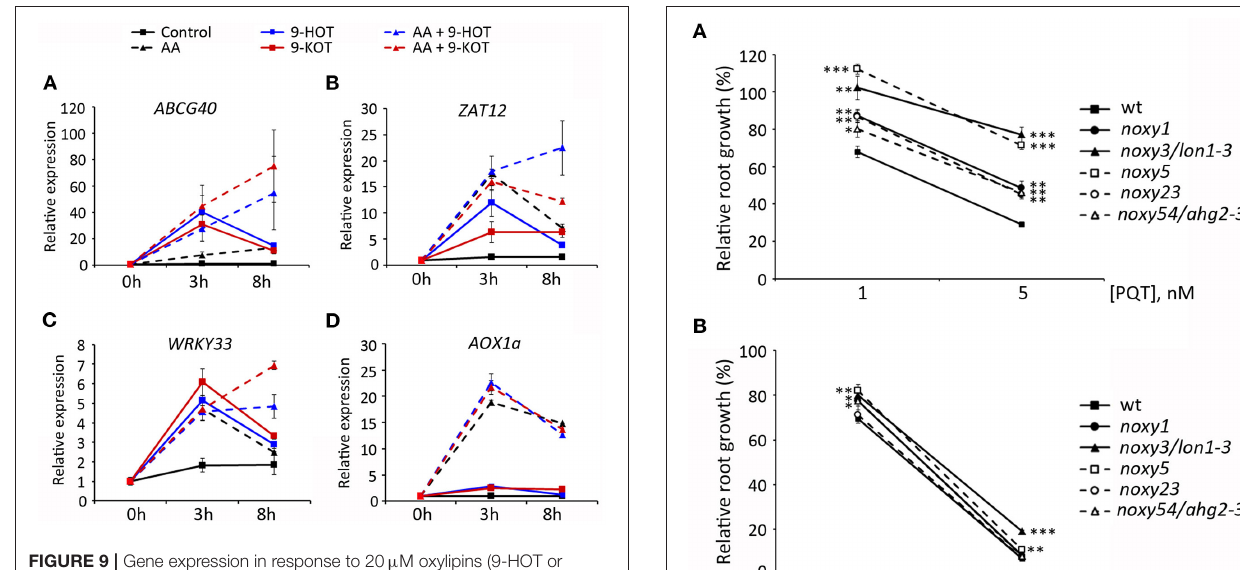
FIGURE 9 | Gene expression in response to 20 µ M oxylipins (9-HOT or 9-KOT), 20 µ M AA or AA/oxylipin combinations. RNA was extracted and examined at the indicated times after treatment. Selected genes were the oxylipin signaling marker ABCG40 (A) , ROS-specific transcription factors ZAT12 (B) and WRKY33 (C) and the mitochondria retrograde signaling marker AOX1A (D) . Expression values are relative to untreated plants, using 18S rRNA and SAND as reference genes.